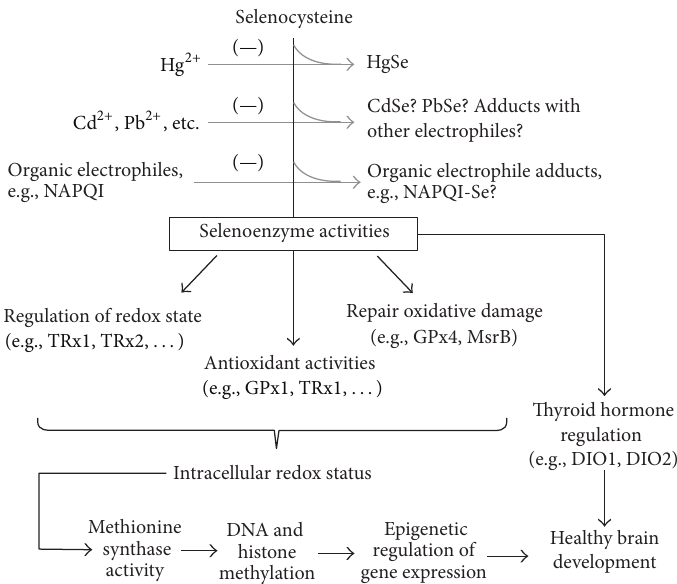
Figure 1: Selenoprotein synthesis and activities are sensitive to elemental and organic electrophiles. High exposures to soft electrophiles may additively impair redox regulation and thyroid hormone production, disrupting epigenetic regulation and normal brain